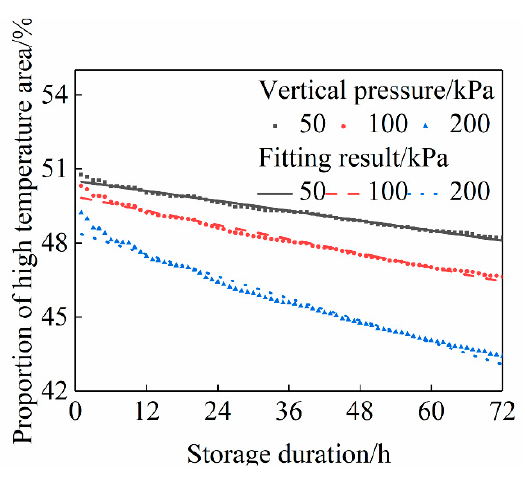
Figure 9. Changes in the high-temperature area with storage duration under different pressures.